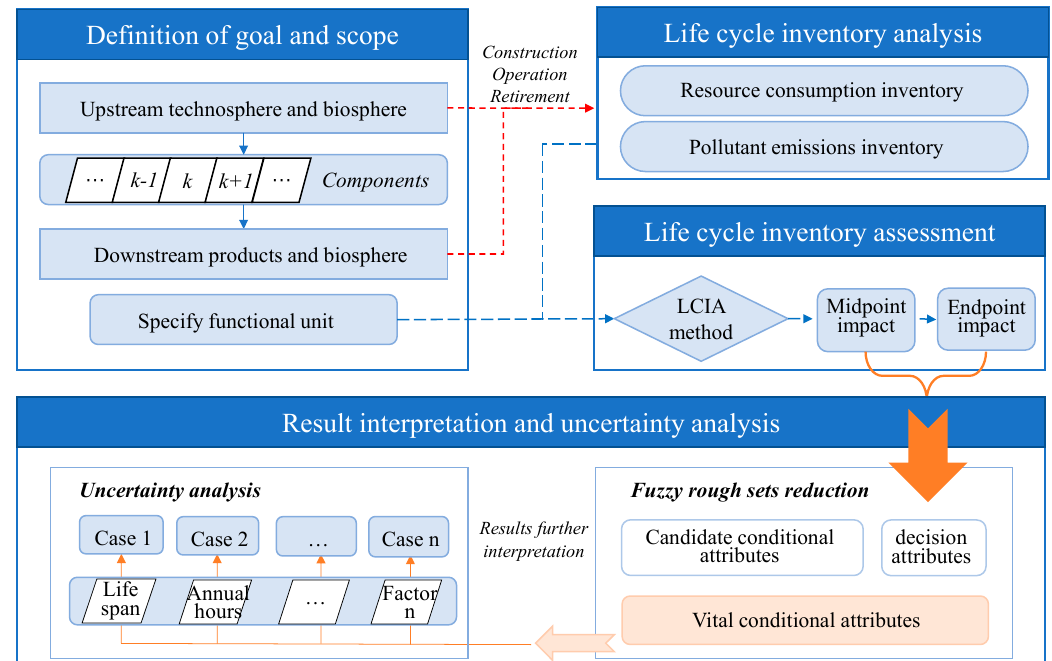
Figure 1. The framework of environmental impact evaluation methods.